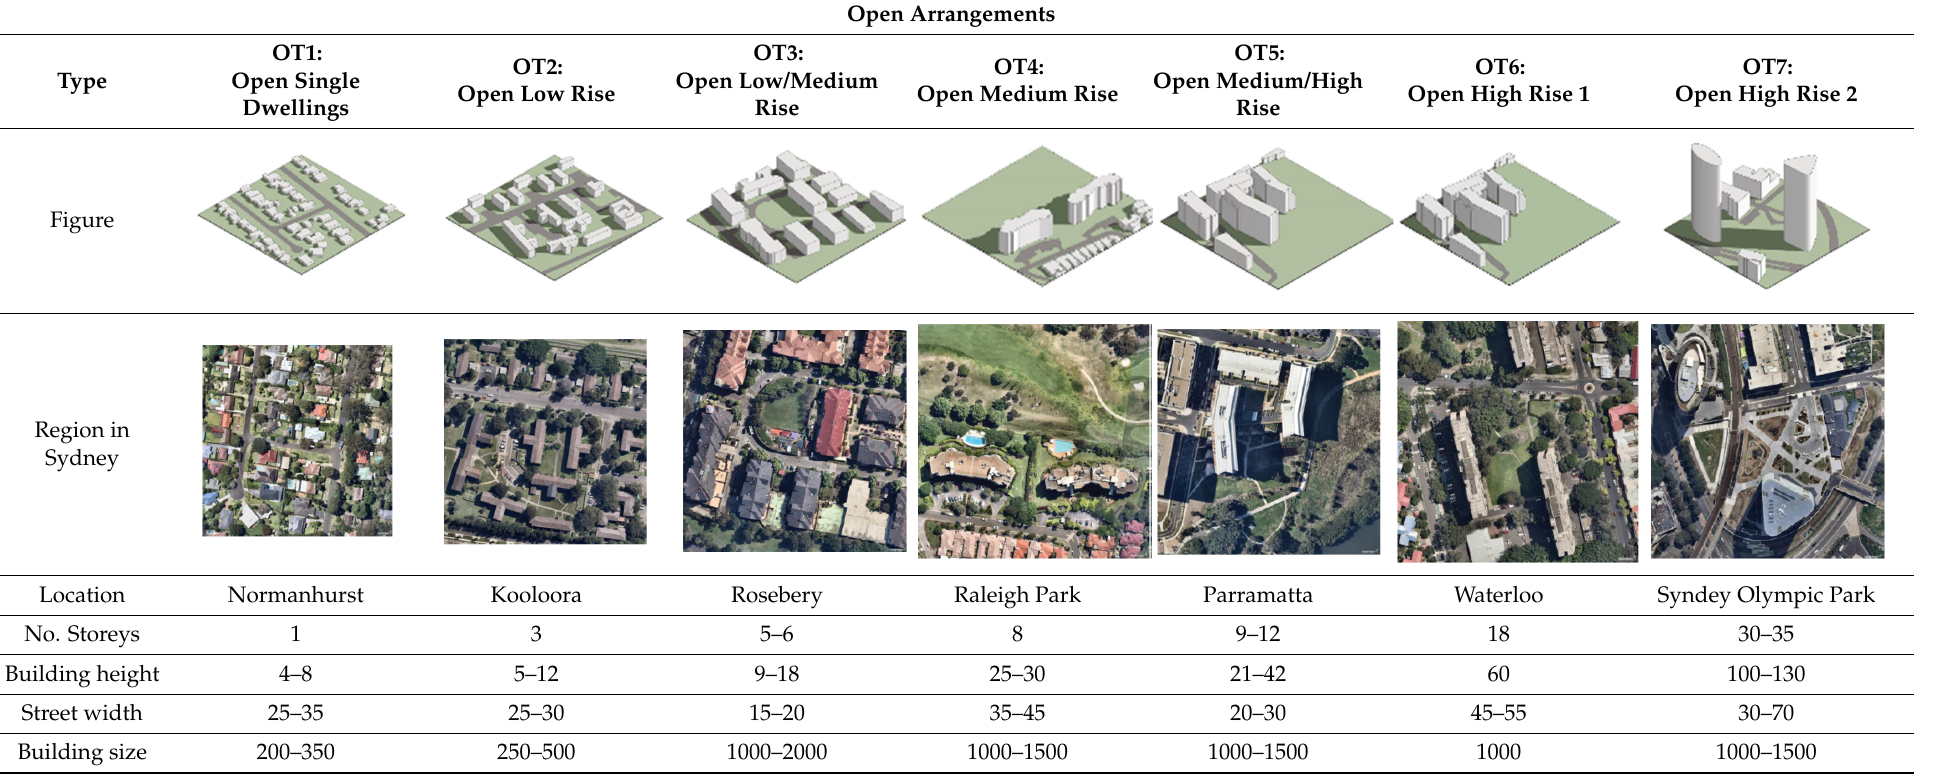
Buildings 2022 , 12 , x FOR PEER REVIEW